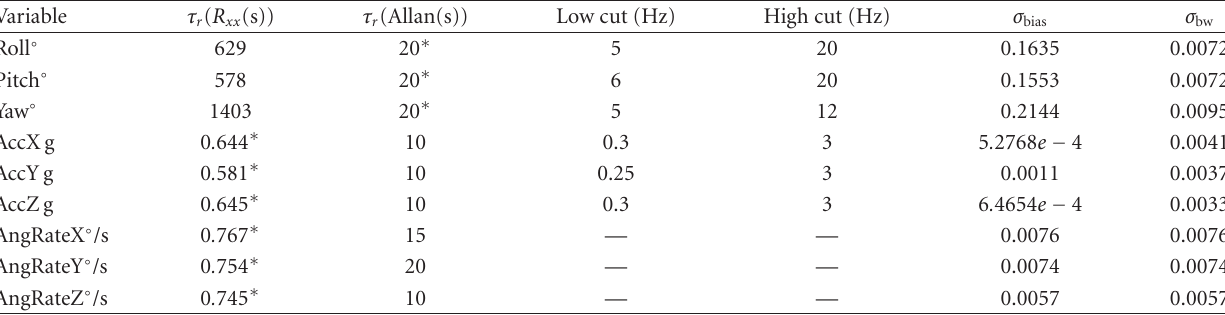
Table 2: Identified parameters for the IMU sensor model 1 .